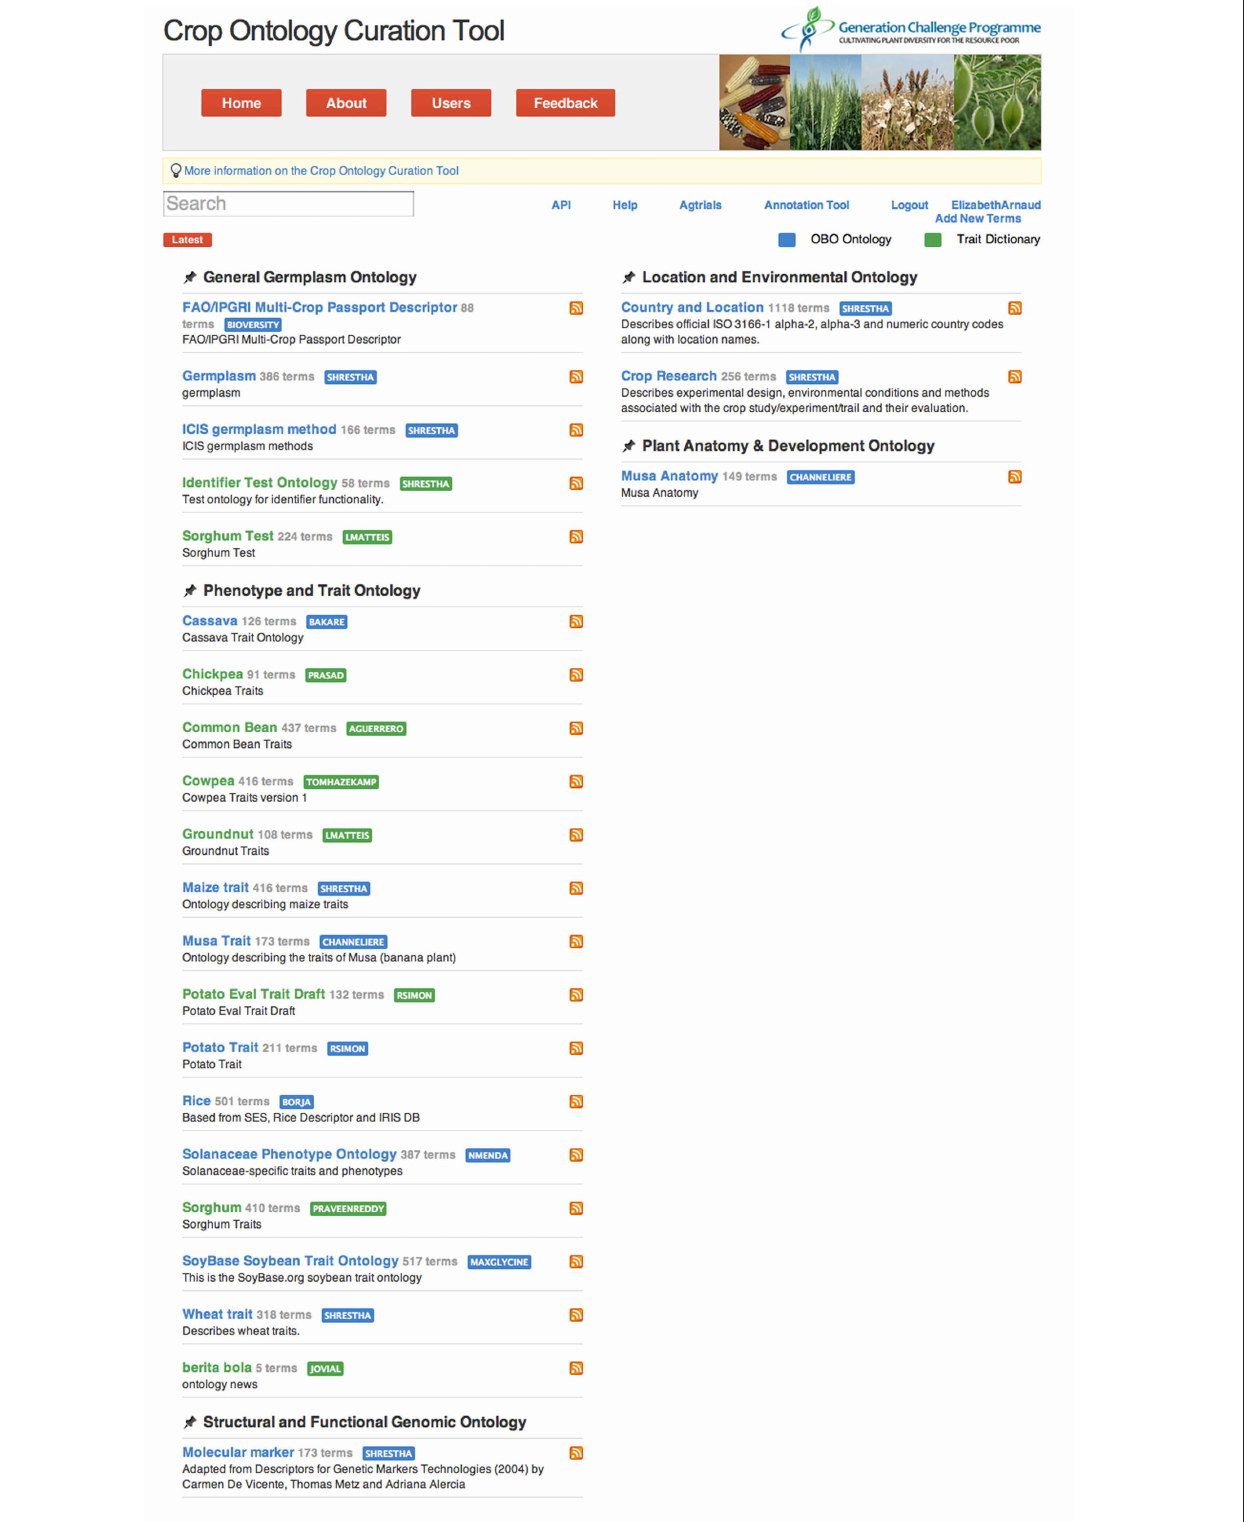
Frontiers in Physiology | Plant